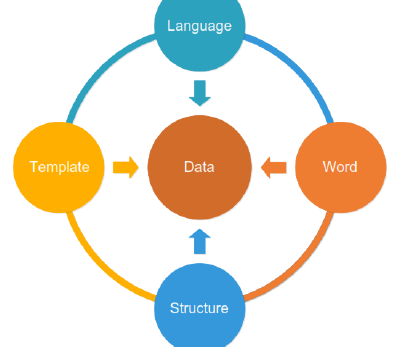
Fig. 12. Generate of Data Lesson.